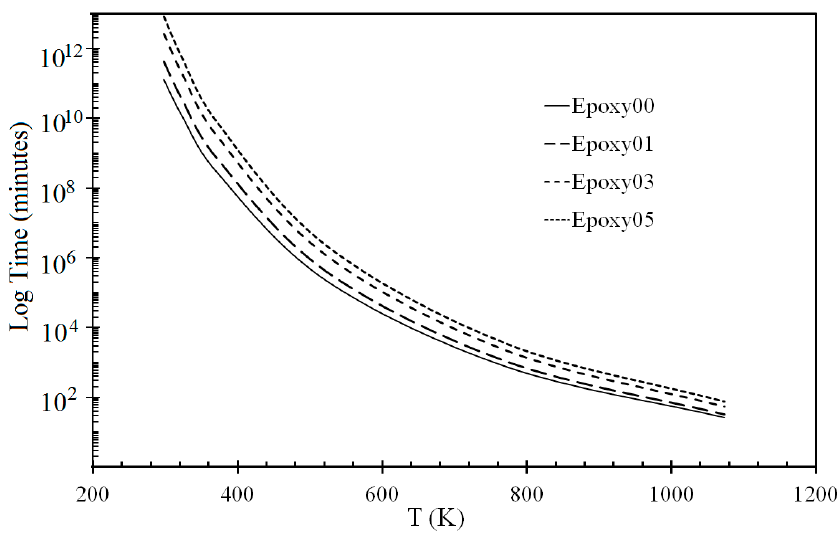
Figure 6. Lifetime prediction. Table 4. Result of kinetic-degradation parameter and lifetime as a function of service temperature in the presence of the type of silicone segment in a nitrogen atmosphere. Sample